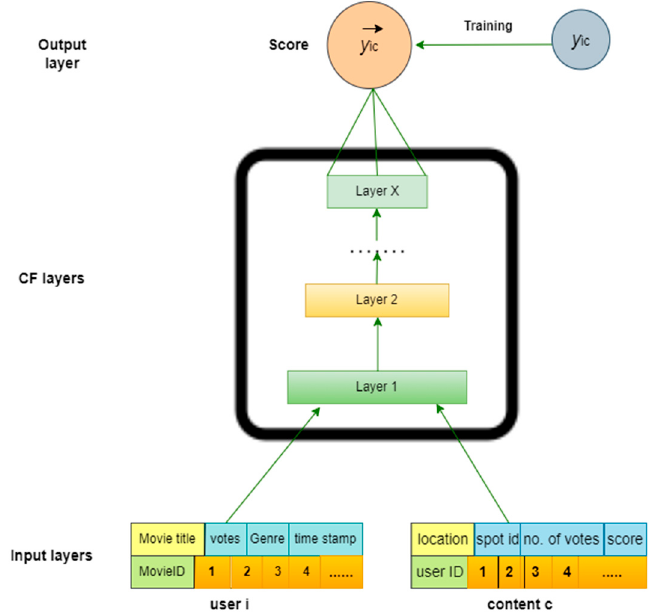
Figure 5. Collaborative filtering (CF) model.